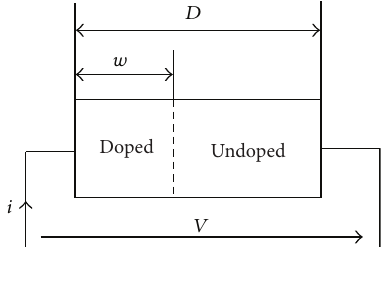
Figure 1: The variable resistor